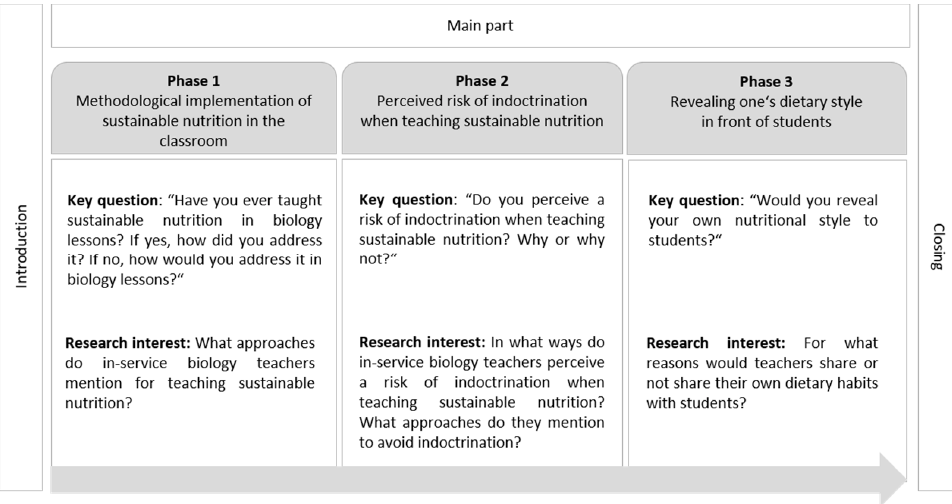
Figure 1. Key Questions and Research Interests of the Three Main Phases of the Interviews.